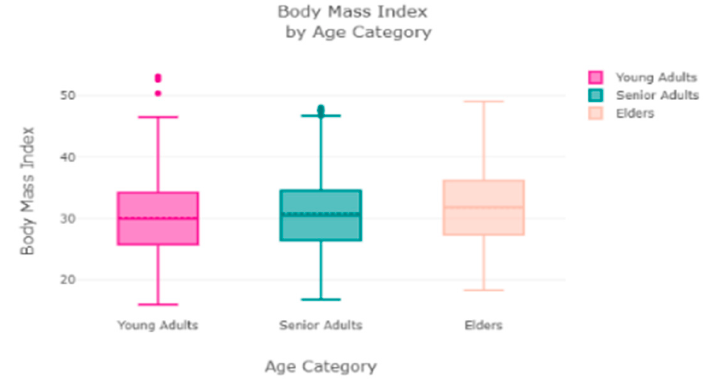
Figure 9. Relationship between “age category” and “BMI”.